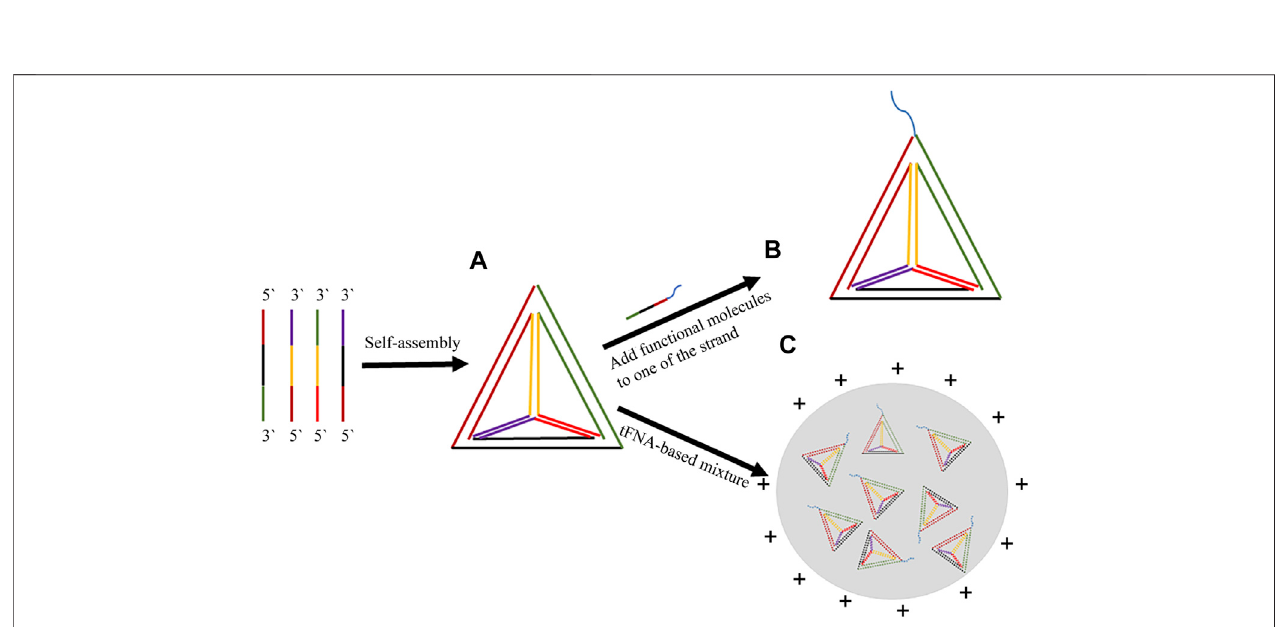
FIGURE 2 | Synthesis and programmability of tFNA-based nanomaterials. (A) Synthesis of tFNA with four strands. (B) Simply adding functional groups such as aptamer, cell-penetrating peptides, et al. to tFNA; (C) TFNA-based mixture.